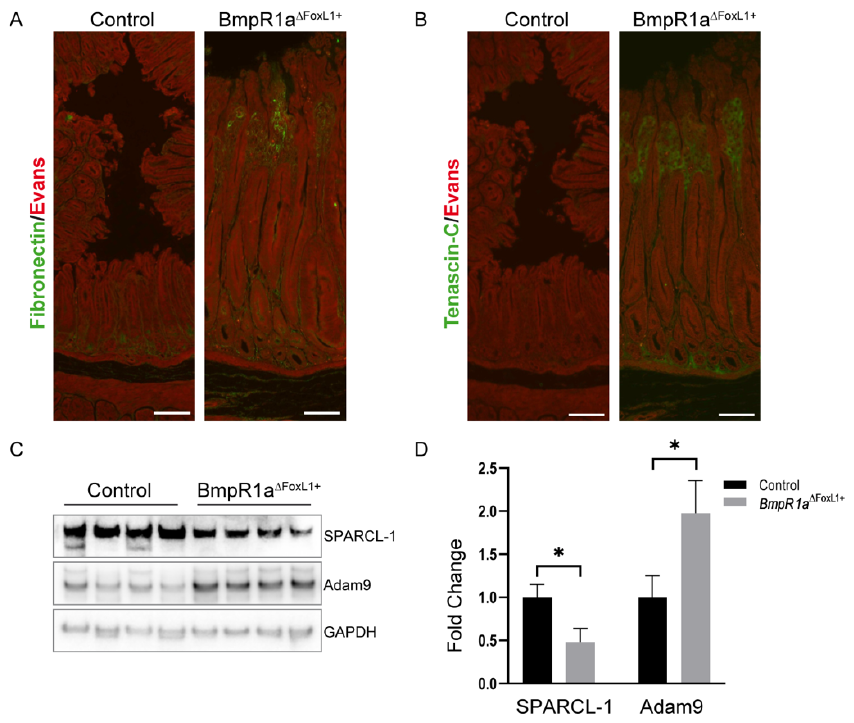
Figure 7. Modulations in ECM glycoproteins and ECM regulator correlate with a neoplasia pheno- type in stomach of BmpR1a △ FoxL1+ mice. ( A ). Immunostaining against ECM glycoprotein fibronectin (shown in green) revealed an increased expression in the enlarged mesenchymal area of the antrum tissue in BmpR1a △ FoxL1+ mice compared to that in controls. ( B ) Immunostaining against ECM glycoprotein Tenascin C (shown in green) revealed an increased expression in the antrum mesenchyme of BmpR1a △ FoxL1+ mice compared to that in controls. ( C ). Immunoblot analysis showed a decrease of the ECM glycoprotein SPARCL-1 expression and an increase of the ECM regulator ADAM9 in total antrum samples of BmpR1a △ FoxL1+ mice compared to that in controls. GAPDH was used as a loading control. ( D ) Quantification of immunoblots revealed a significant modulation of SPARCL-1 and ADAM9 between both group (FC = 0.48 and 1.98, respectively). All quantifications were performed using ImageJ and statistical analyses were performed using Prism. All immunoblot quantification data are presented as the mean ± SD ( n = 4). Statistical analysis was assessed using the Mann–Whitney test with * p < 0.05. Evans blue was used as a counterstain (red signal in A and B). Scale bar = 100 µm.